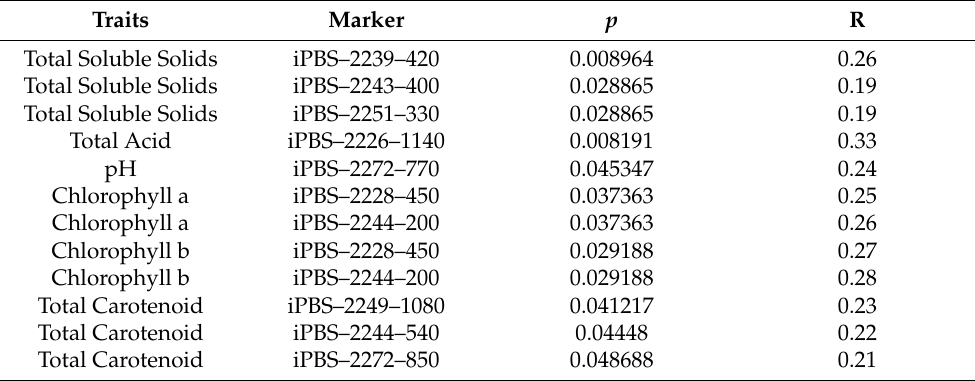
Figure 4. ( a ) ∆ K values for parsley genotypes. ( b ) L(K) values for parsley genotypes. ( c ) Proportions of the ancestry of 18 parsley accessions based on K = 2 (where K is the number of initial subpopulations, each indicated with a different color). Table 6. Associating mapping results for some characters using the GLM (General Linear